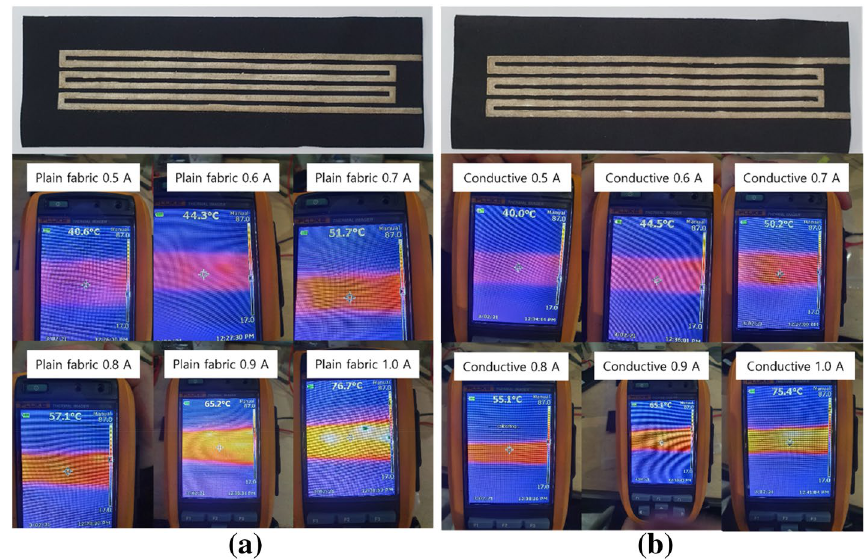
Fig. 5 Test sample and its heating images at various magnitudes of applied current. Plain fabric ( a ), conductive fabric with CNT ( b